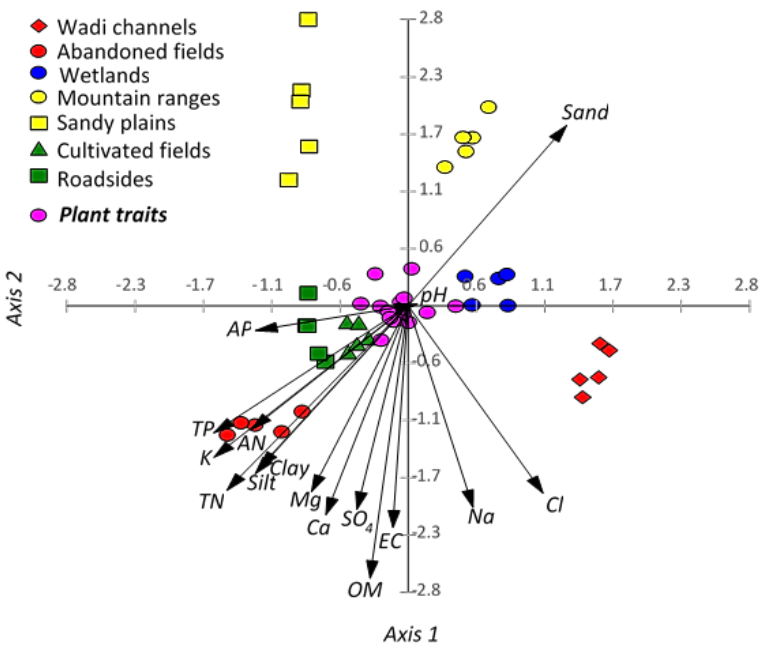
Figure 4. Canonical correspondence analysis (CCA) showing the correlations among the soil variables, habitats, and functional traits of Argemone ochroleuca . TN: total nitrogen, AN, available nitrogen, TP: total phosphorus, AP: available phosphorus, EC: electrical conductivity, and OM: organic matter.